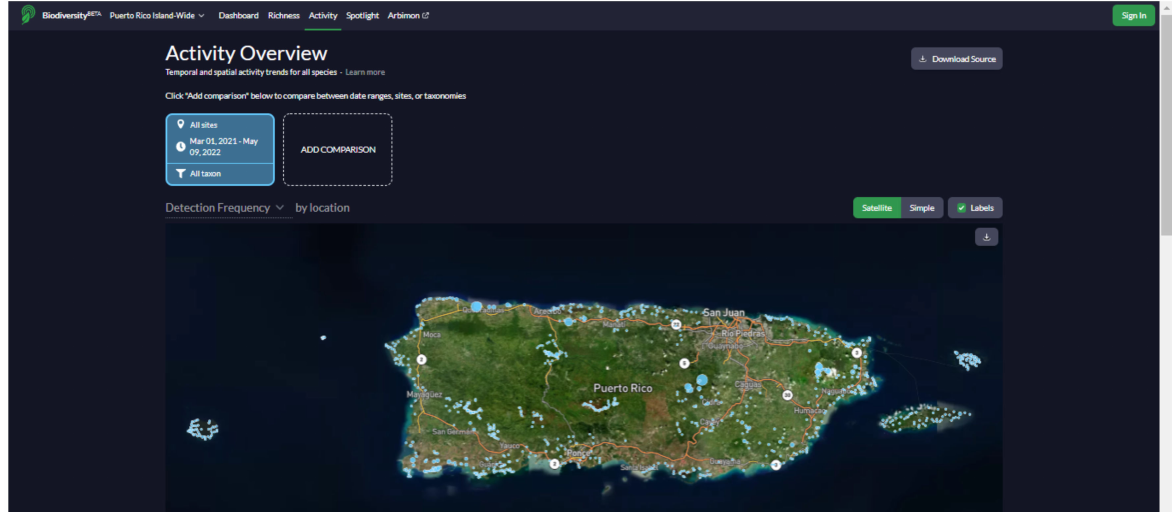
Figure A21. Activity Overview: This page offers an overview of temporal and spatial vocal activity patterns. It can be used to summarize detection frequency, number of raw detections, or naive occupancy results (i.e., proportion of occupied sites), with a focus given to general patterns at the community level. As with the Richness page, the user can use the filters to select results from taxonomic groups, sampling sites, or specific periods and visualize the results in a map or graphs that present the results according to the hour, day of the week, or